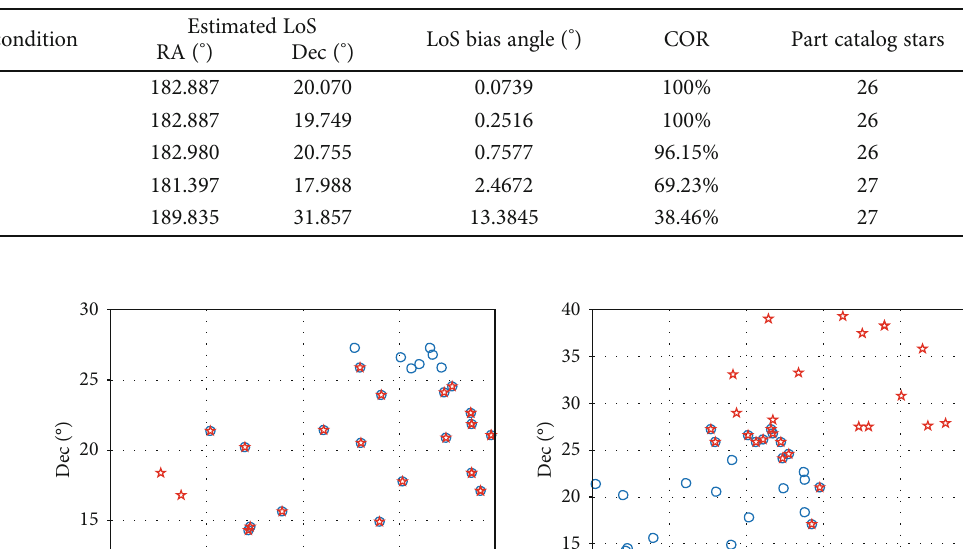
Table 3: Statistics in the 4060 s epoch for 5